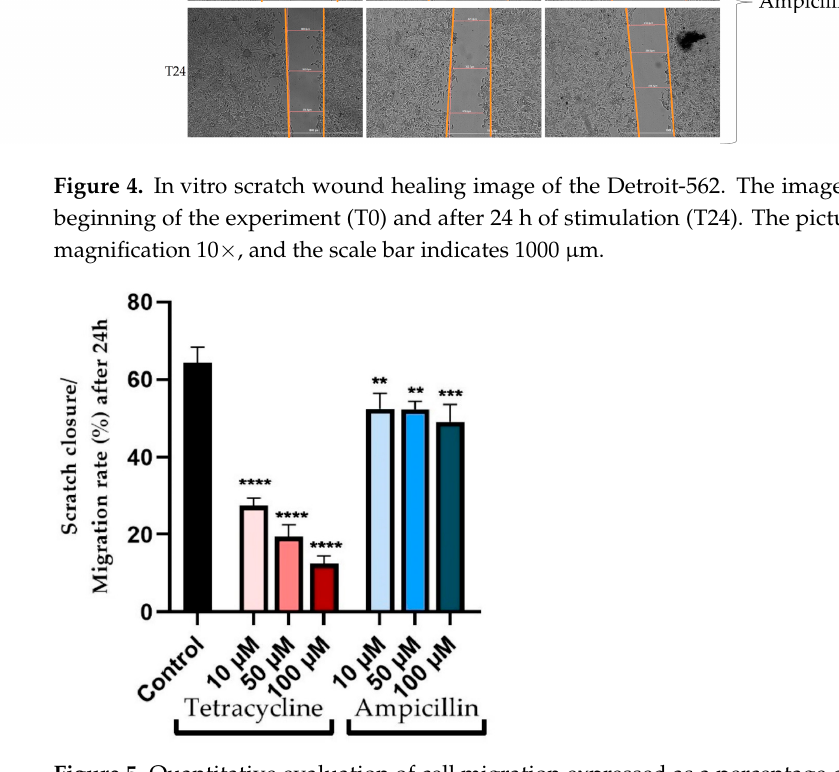
Figure 5. Quantitative evaluation of cell migration expressed as a percentage compared to control (non-stimulated) cells. The results are expressed as mean values ± SD of three independent experi- ments performed in triplicate. The statistical differences between control and cells stimulated with tetracycline and ampicillin were determined by applying the one-way ANOVA analysis followed by the Dunnett’s multiple comparisons post-test (** p < 0.01; *** p < 0.001 and **** p < 0.0001).